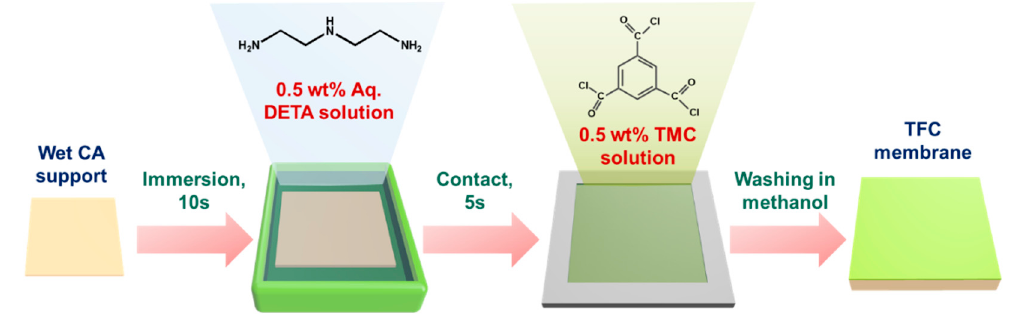
Figure 1. Schematic diagram for membrane preparation.